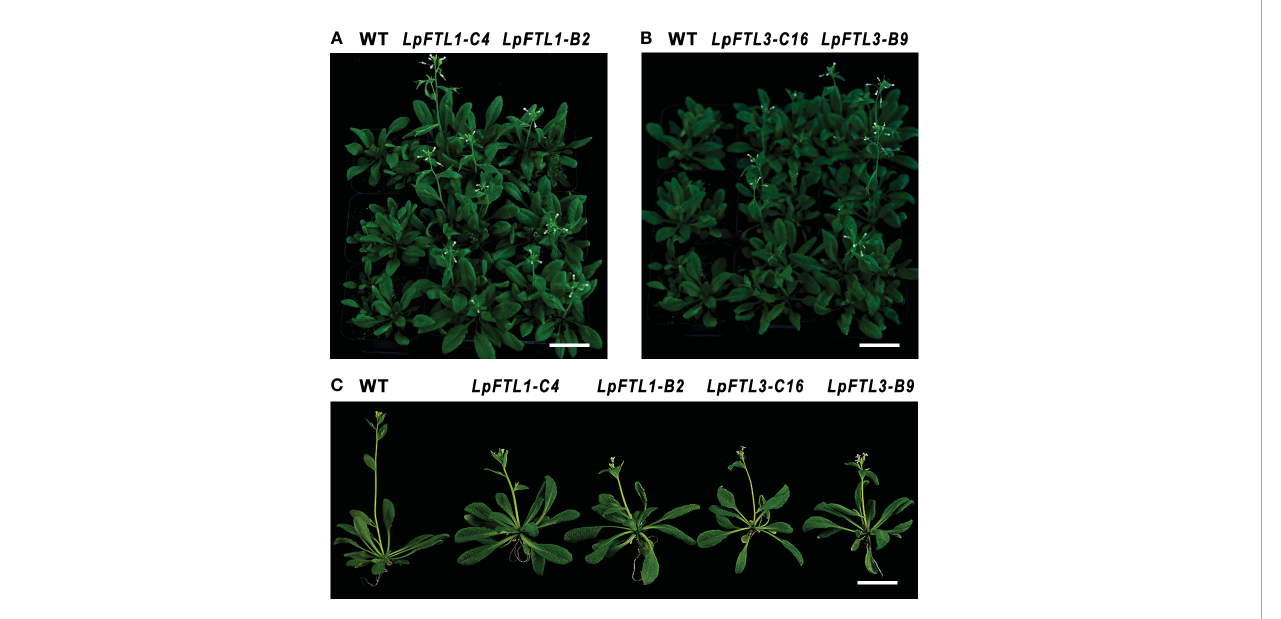
FIGURE 4 Appearance of 36-day-old wild-type WT, FTL1-C4, FTL1-B2 (A) and FTL3-C16, FTL3-B9 (B) . Florescence state of transgenic Arabidopsis line (C) .